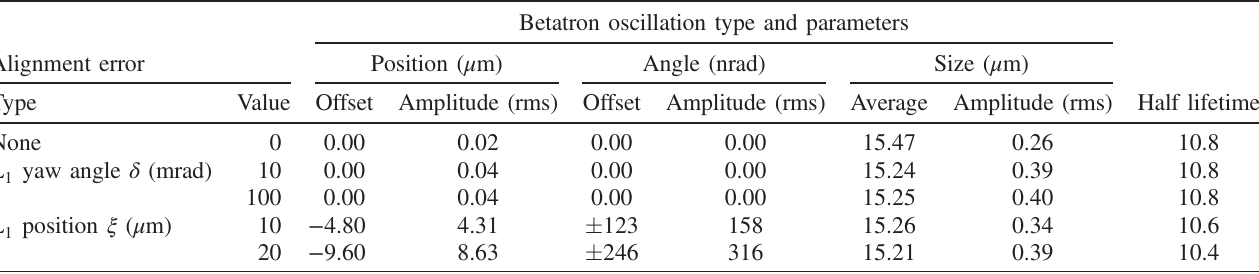
TABLE V. X-ray beam characteristics at the source position simulated for the cavity with yaw angle error δ or lateral spatial error ξ of one lens derived from the data in Figs. 17 – 18. A second sign for offset values is provided if the sign differs between the source and the